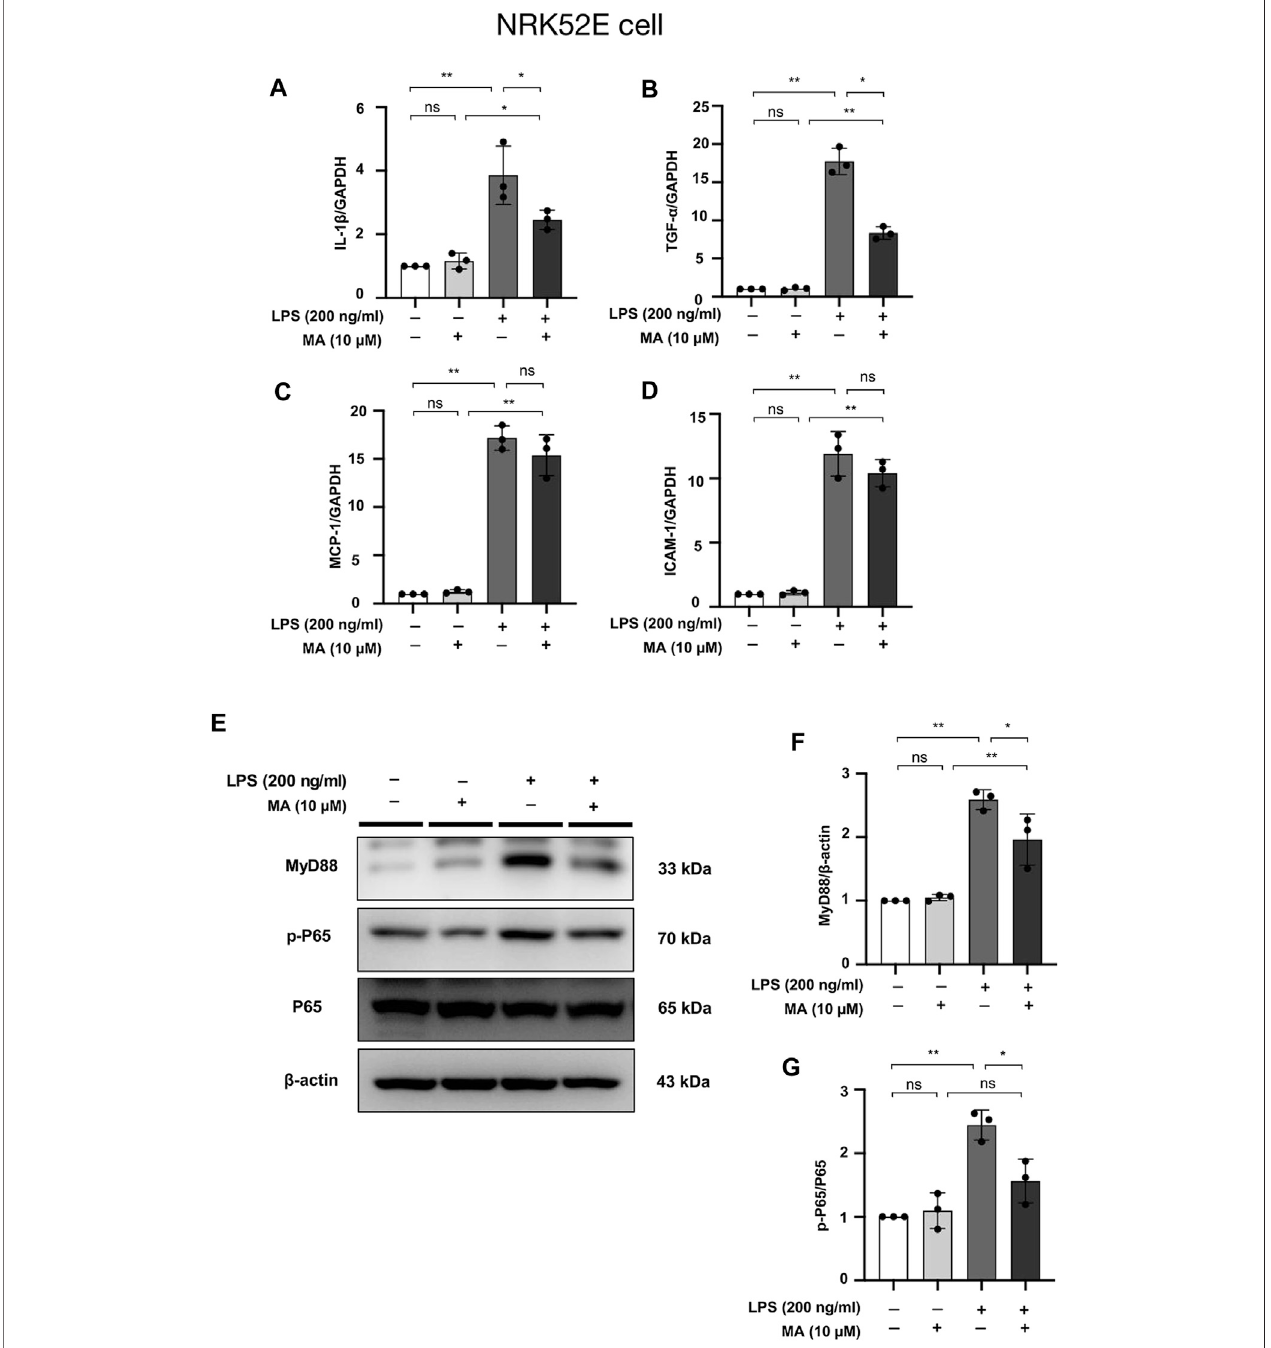
FIGURE10| MAattenuatesLPS-inducedin fl ammationinNRK52EcellsandsuppressesNF- κ BSignaling. (A – D) mRNAexpressionlevelsofIL-1 β ,TNF- α ,MCP-1and ICAM-1wereevaluatedinLPS-treatedNRK52EcellsanddeterminedbyRT-PCR.CellswerepretreatedwithMAfor2 hafterstarvationwith0.5%FBSmedium,thentreated withLPS(200 ng/ml)for2 h.ResultswerenormalizedtoGAPDHexpression.Thedataarepresentedasthemean ± SD, n (cid:1) 3.* p < 0.05,** p < 0.01,ns:nosigni fi cance.MA, maslinic acid; LPS, Lipopolysaccharide; RT-PCR, Real-Time PCR. (E) Expression of p-P65, P65 and MyD88 in LPS-treated NRK52E cells was detected by western blot and quanti fi ed by densitometry. Cells were pretreated with MA for 2 h after starvation with 0.5% FBS medium and then treated with LPS (200 ng/ml) for 2 h. (F,G) Statistical signi fi cance was presented as the mean ± SD, n (cid:1) 3. * p < 0.05, ** p < 0.01, ns: no signi fi cance. MA, maslinic acid; LPS, Lipopolysaccharide.